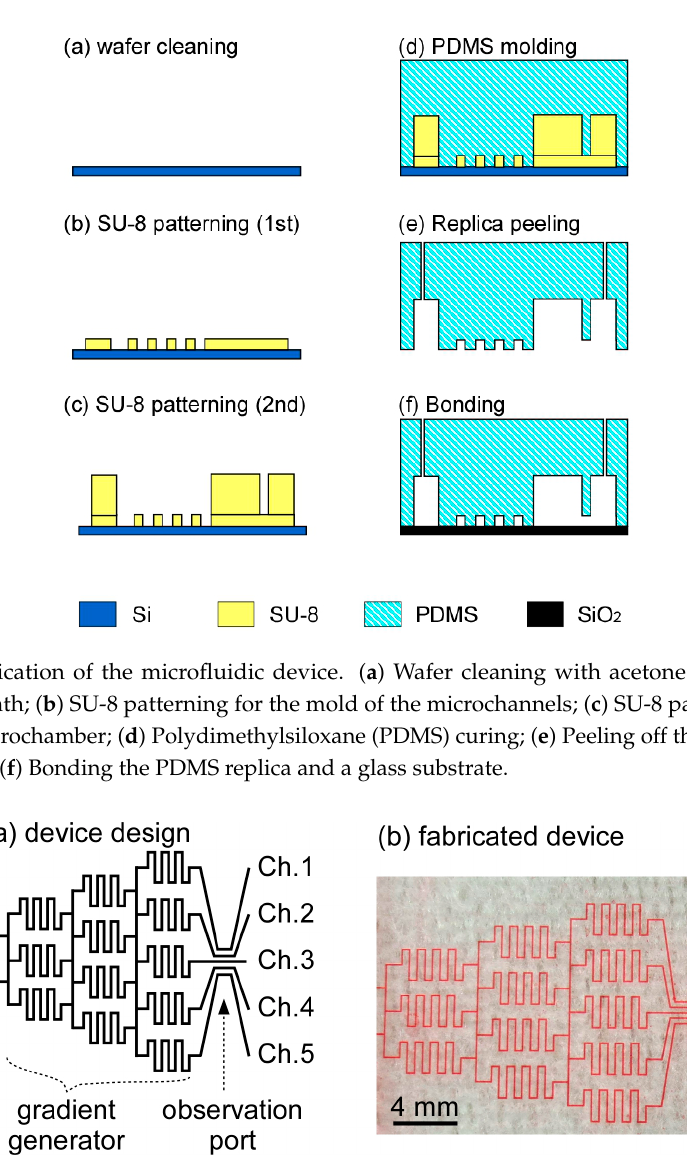
Figure 3. Microfluidic concentration gradient generator. ( a ) Device design. The gradient generator produces 5 different glucose solutions downstream. The microchannels are defined as Ch. 1–5; ( b ) Fabricated device filled with red-dyed solution.